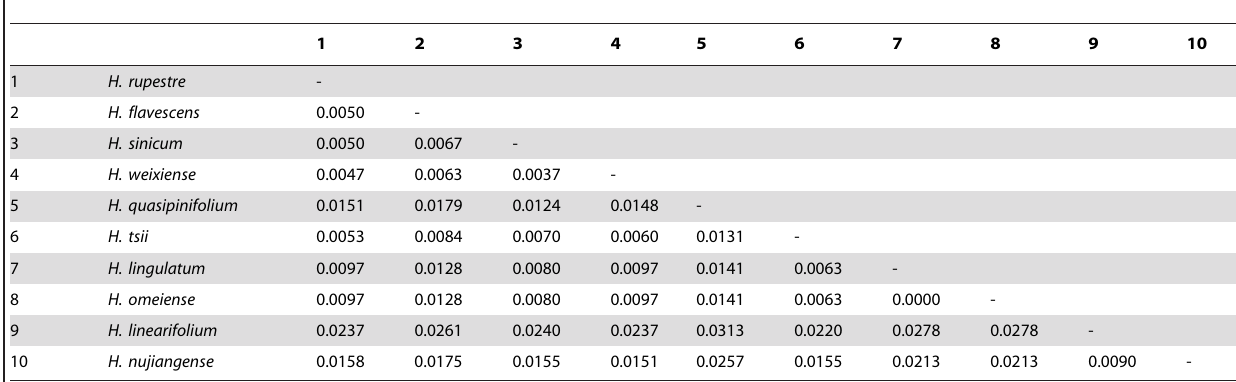
Region AIC select model Base frequencies